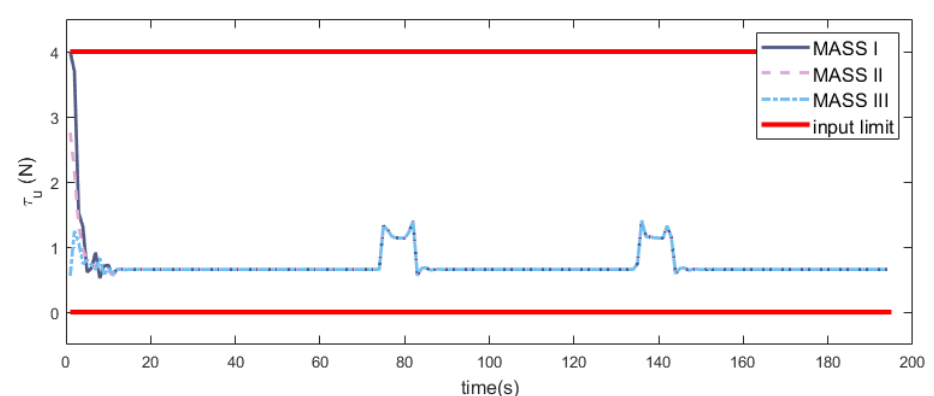
Figure 8. Surge velocity of MASSs.